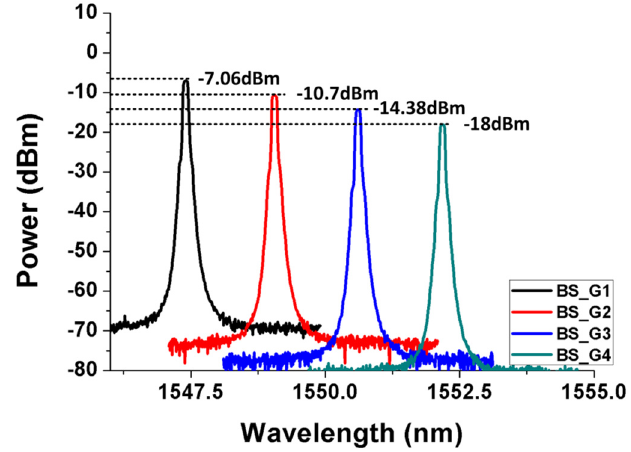
Figure 5. Overlapped uplink optical spectra measured at the CO end of each BS-Group.